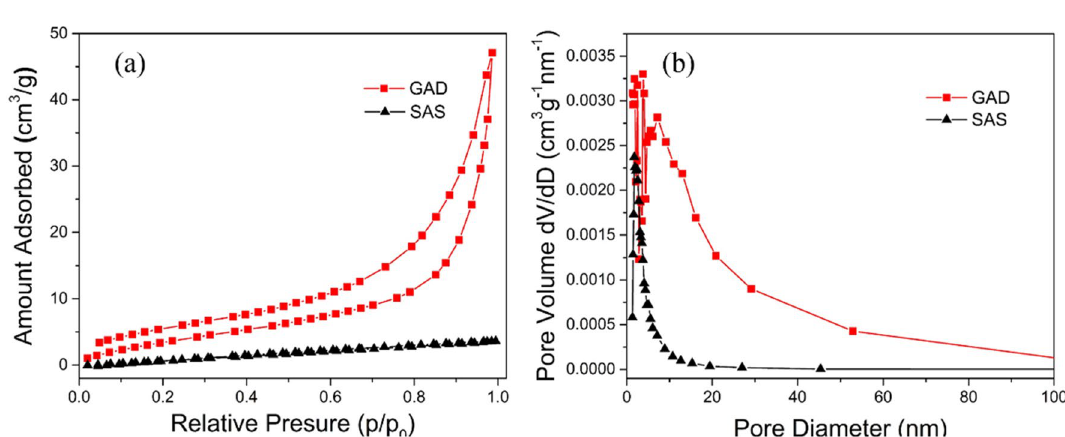
Figure 3. ( a ) N 2 adsorption and desorption isotherm and ( b ) pore size distributions of GAD and